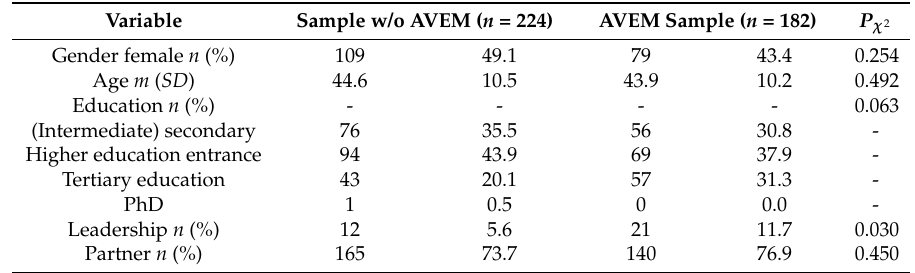
Table 1. Sample characteristics of the financial services company’s employees and p -values of the χ 2 difference tests.